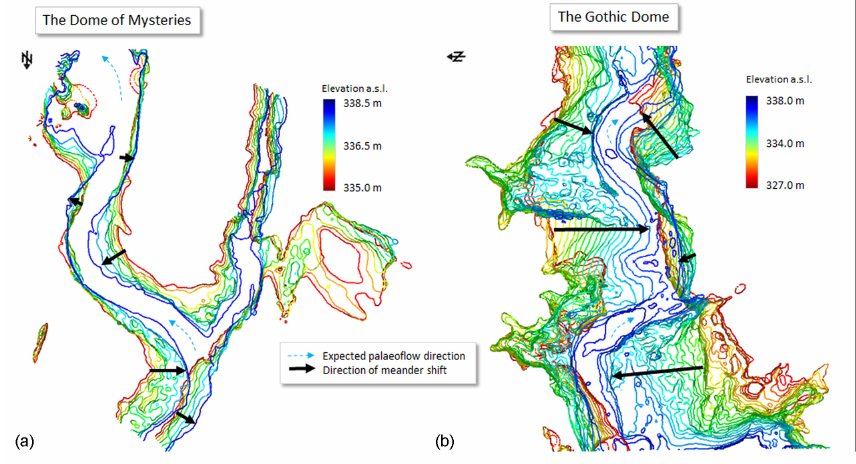
Figure 12. Elevation contours of the 3-D cave surface projected on a horizontal plane indicate upward migration of the ceiling meanders in the Dome of Mysteries (a) and in the Gothic Dome (b) . Contour interval is 0.5m.